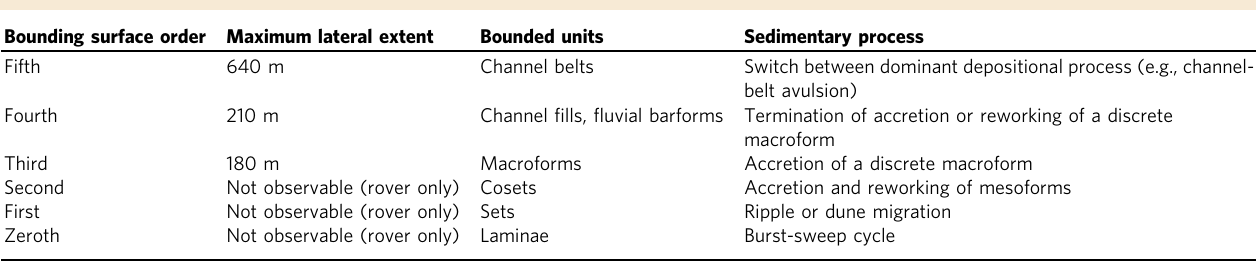
First Ripple or dune migration Zeroth Not observable (rover only) Laminae Burst-sweep cycle Bounding surface ranking and process interpretations adopted from previous studies 22,62